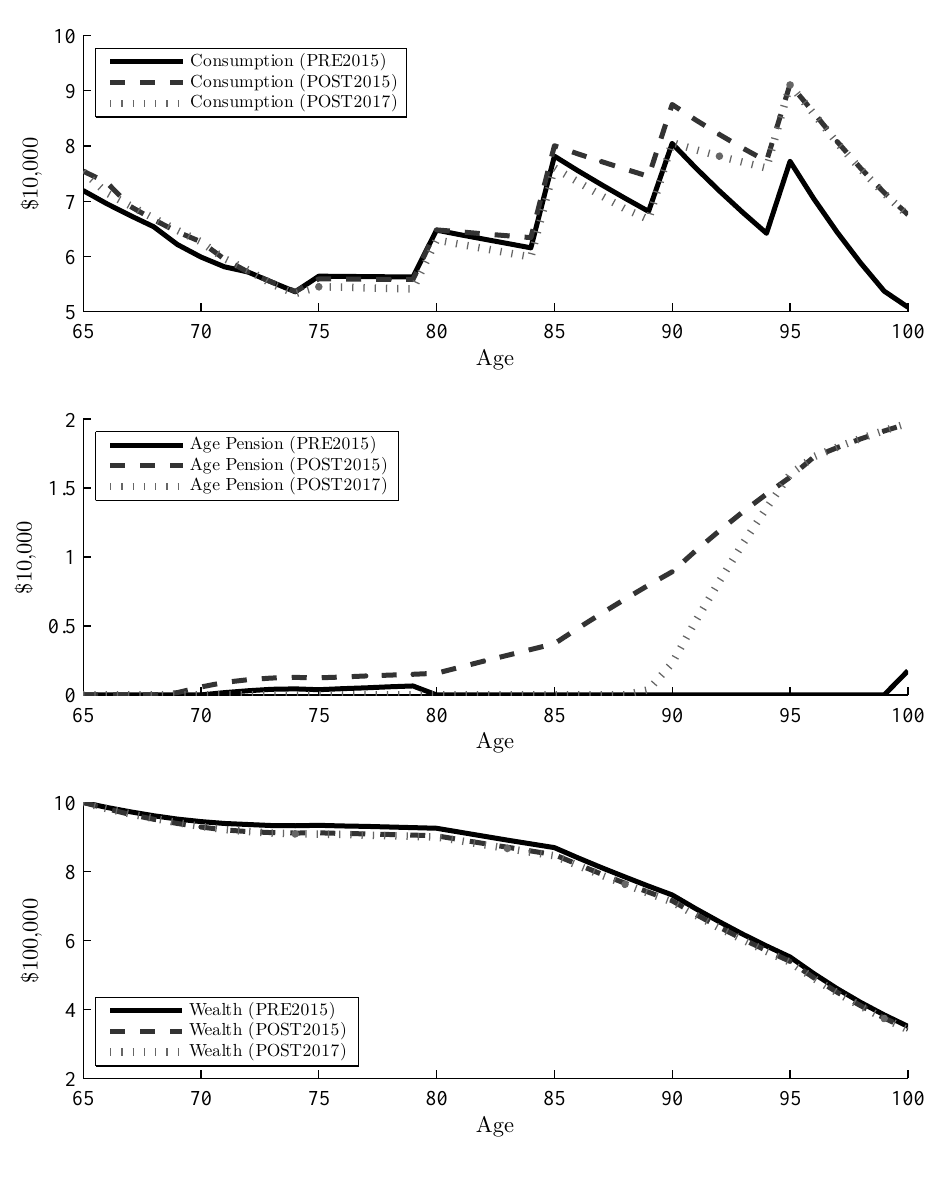
Figure 3. Comparison of consumption, Age Pension and wealth over a retiree’s lifetime with the three different policy scenarios. The retiree starts with $1m liquid wealth, which grows with the high expected return each year ( µ = 0.06), and drawdown follows the optimal drawdown paths under each